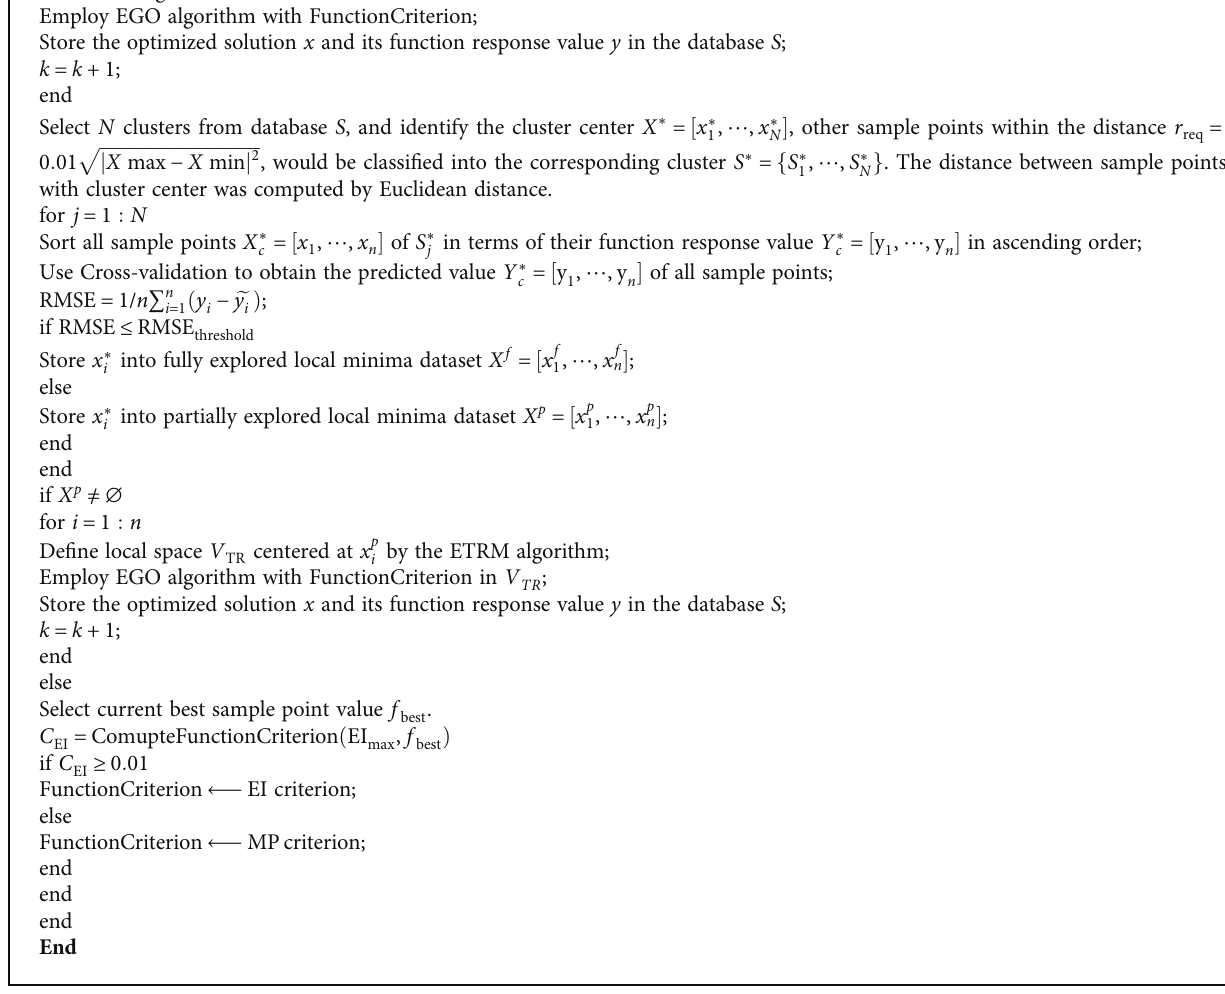
Algorithm 1: The encoding type of